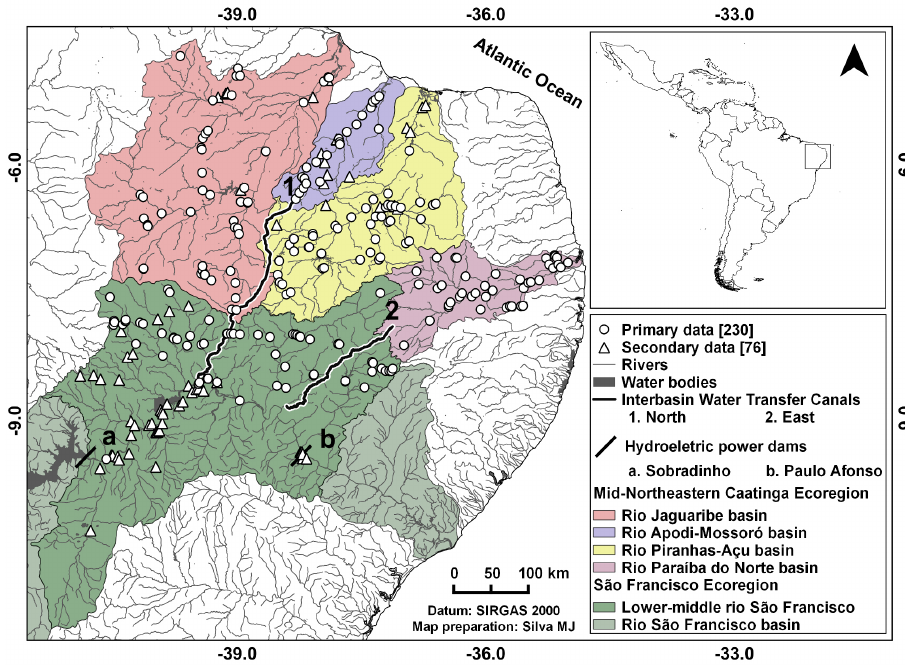
FIGURE 1 | Sampling sites of the freshwater fish species in the São Francisco Interbasin Water Transfer Project basins in the Brazilian